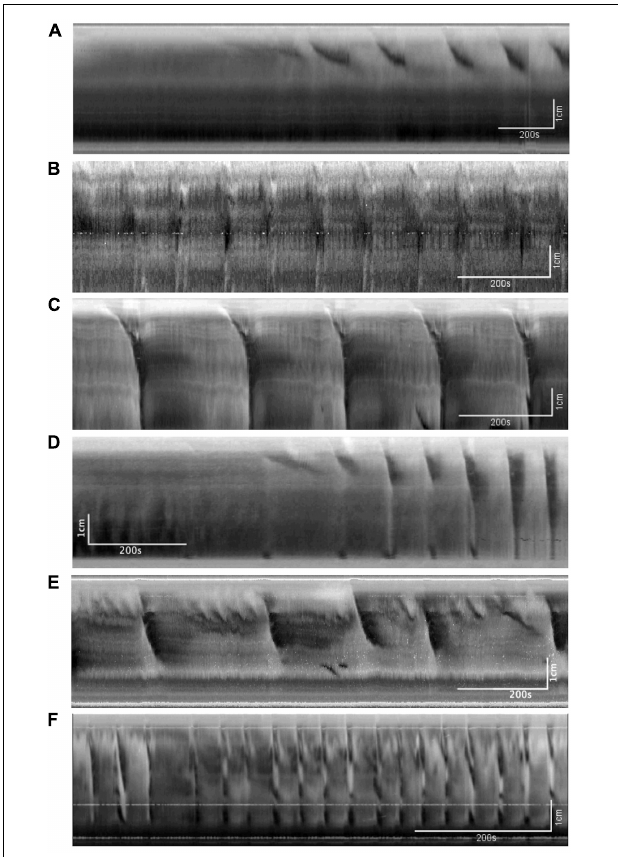
FIGURE 2 | The colonic motor complex (CMC) at different levels of excitation. In this and all subsequent figures, black identifies contraction, and white relaxation or distention; the top of all figures is the proximal part of the colon. (A) Upon mild excitation by increased intraluminal pressure, proximal rhythmic (pacemaker) activity appear in the colon always starting in the most proximal pacemaker activity. These are usually rhythmic, and almost always start in the proximal colon to propagate a short distance. (B) Fast propagating contractions (FPCs). Further excitation may elicit a CMC, which is always rhythmic and triggered by proximal activity. The weakest form of CMCs presented as single FPCs, clustered-FPCs or a mix of short contractions that together form a complex of pan-colonic activity. (C) Long distance contractions (LDCs). Full-blown LDCs are shown here, which are manifestations of CMCs at their highest level of excitation. (D) This figure shows how proximal rhythmic contractions can develop from proximal activity to eventually trigger LDCs. (E) This figure shows how proximal activity can occur rhythmically and at a high frequency where only every 3rd or 5th activity triggers an LDC. (F) “Broken” long distance contractions. The CMC can show many compositions in between low-amplitude FPCs and full-blown LDCs. Here we see many LDCs we have previously identified as “broken LDCs” (Chen et al., 2013), where it appears that the LDC is interrupted by one or many streaks of